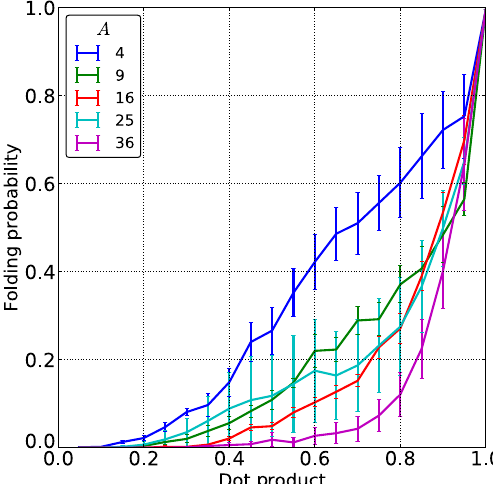
FIG. 11. Large meshes require the applied vector of torques ⃗ τ to of the desired be closely aligned with the folding angles ⃗ ρ desired branch for successful folding. By folding random quadrilateral meshes of different sizes with random ⃗ τ and determining the success of folding, we find that the dot product D ¼ ⃗ τ · ⃗ ρ = ∥ ⃗ τ ∥∥ ⃗ ρ ∥ in a large quadrilateral mesh must be desired desired close to 1. Since most vectors in high-dimensional space are orthogonal, only a vanishingly small fraction of applied vectors of torques can successfully fold the desired